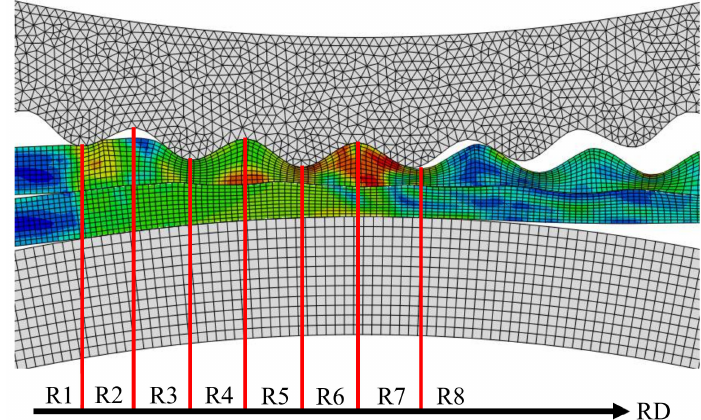
Figure 2. Zoning diagram of the corrugated rolling deformation zone.